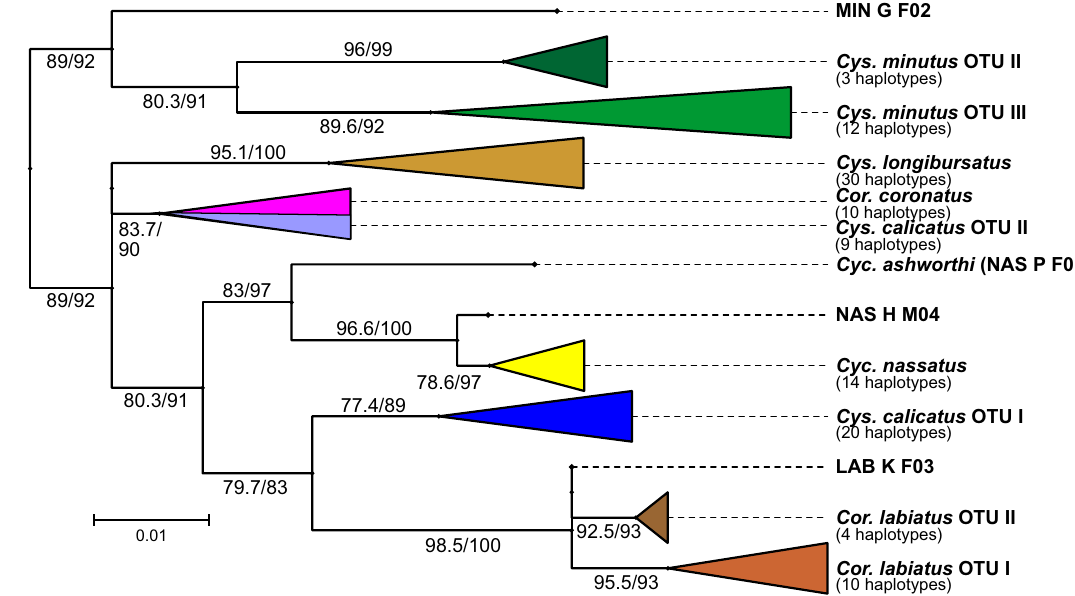
Figure 1. Maximum likelihood phylogenetic tree calculated using aligned ITS-2 sequences after condensing. The tree was manually rooted placing Cylicostephanus minutus at the base of the tree due to previous analysis on a larger number of species 55 . The scale bar represents 0.01 substitutions per site and node support was obtained by ultrafast bootstrapping (1000 replicates) after and the Shimodaira-Hasegawa likelihood ratio test before the slash. Individual specimens that were not assigned to one of the major clades are designated according to the following code: MIN, NAS, LAB for the species Cylicostephanus minutus, Cylicocyclus nassatus, Coronocyclus labiatus , respectively; G, H, P, K, D, Z for the hosts German horse, Ukrainian horse, Przewalski’s horse, kulan, donkey and zebra, respectively; F/M for female or male; a number indicating the individual specimen. OTU, operational taxonomic